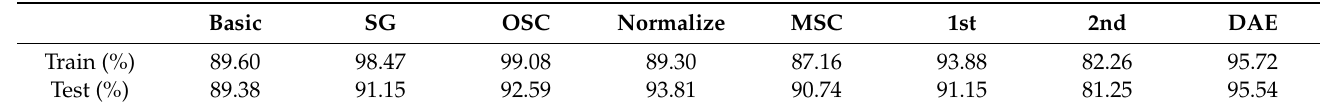
Table 1. Comparison of various data addition models, the first column (Basic) is the result of not using these methods to augment the data.